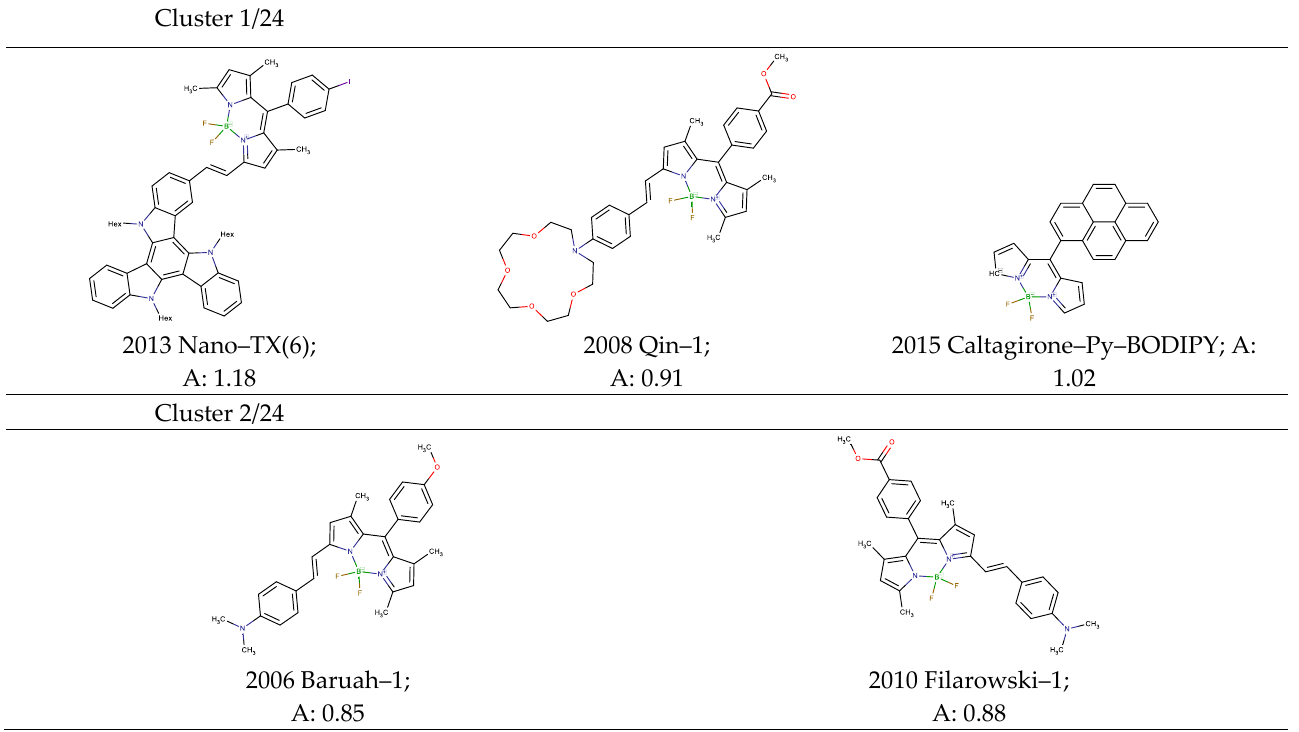
ular behavior for dyes bearing a high positive and high negative solvatochromic sensitiv-